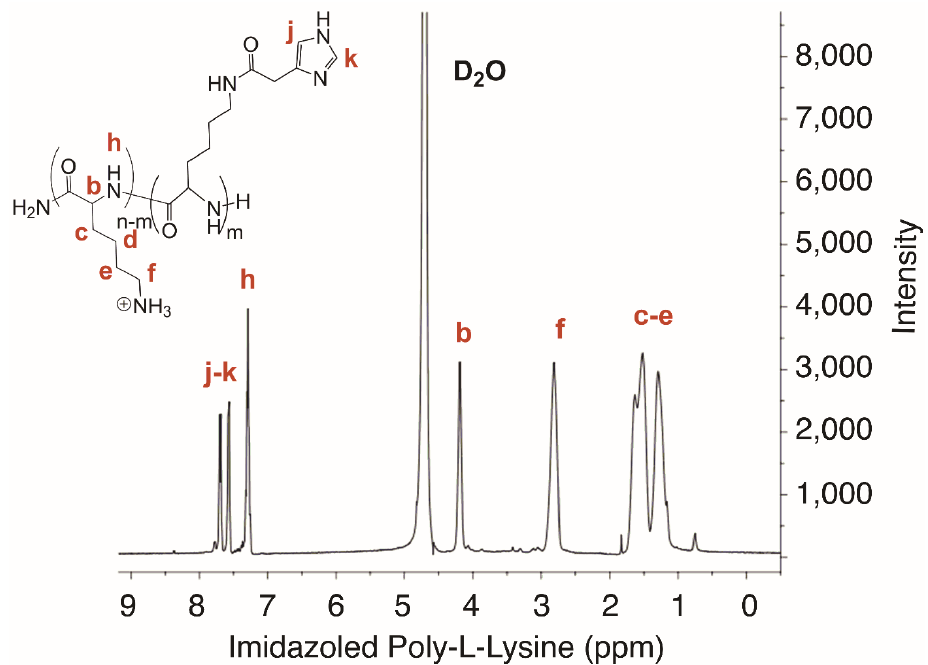
Figure 2. 1 H NMR spectrum of imidazole poly-L-Lysine (PLI) in D 2 O at room temperature (400 MHz, D 2 O, ppm).